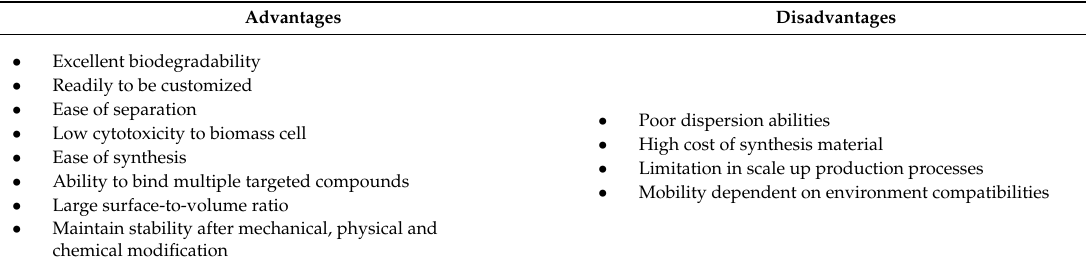
Table 1. Advantages and disadvantages of magnetic nanoparticles